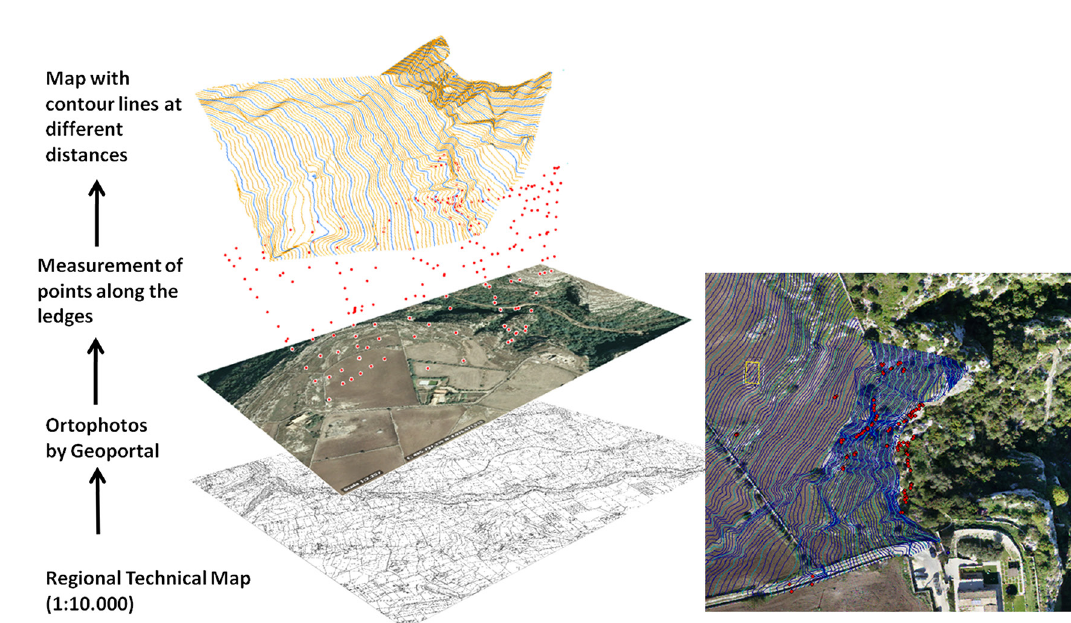
Figure 7 . Topographical outputs of the